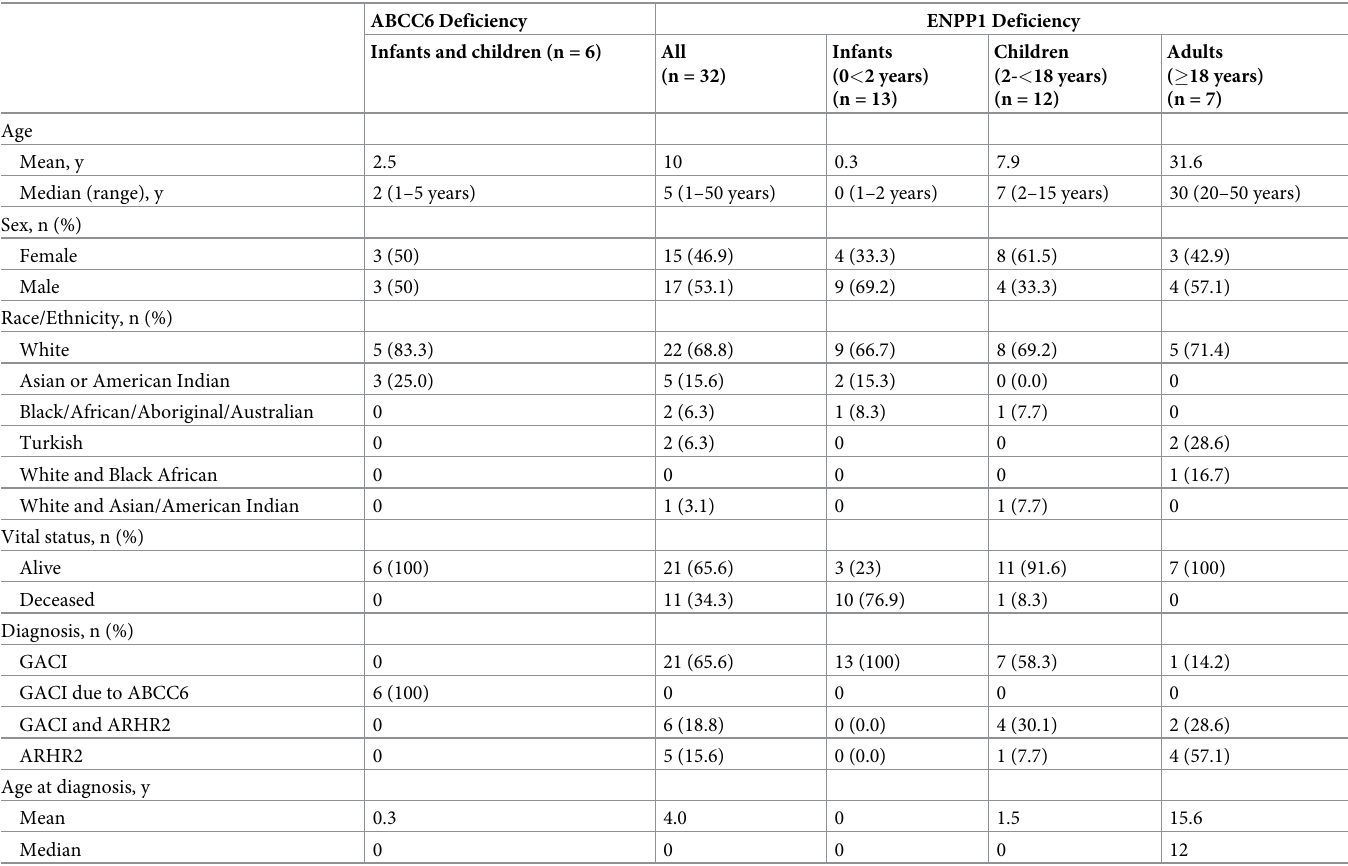
Table 1. Demographics and characteristics of the study